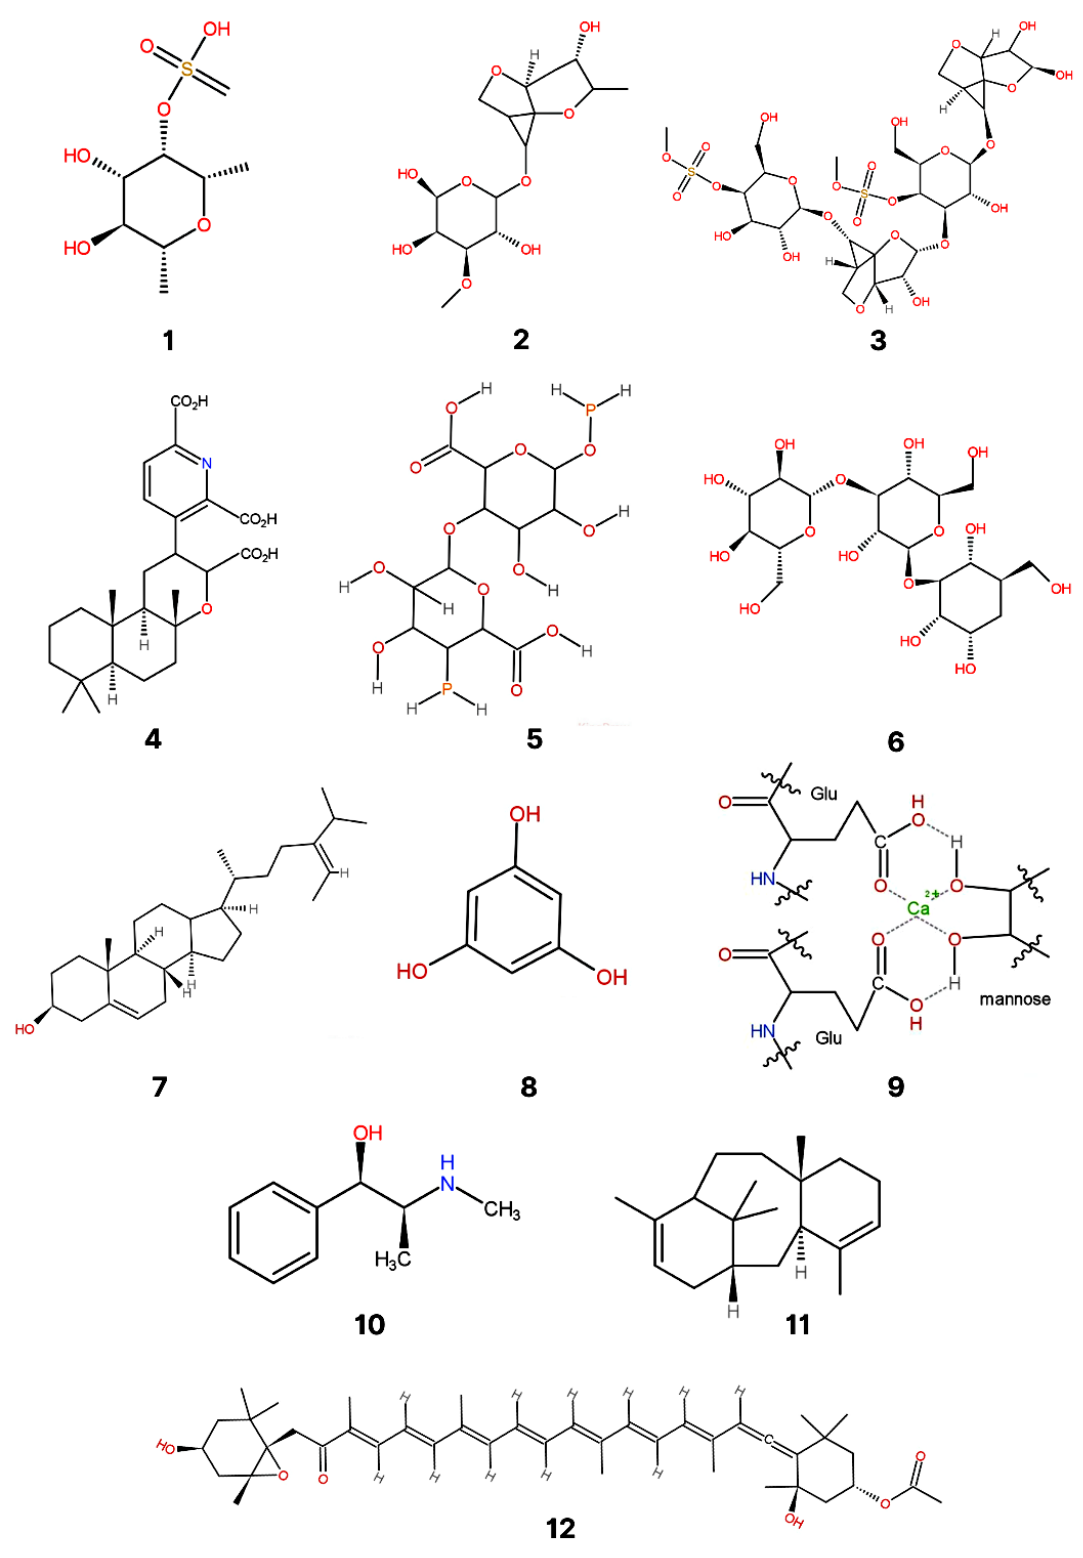
Figure 3. The chemical structures of fucoidan ( 1 ), agars ( 2 ), kappa carrageenans ( 3 ), ulvans ( 4 ), alginates ( 5 ), laminarin ( 6 ), fucosterol ( 7 ), phlorotannins ( 8 ), lectins ( 9 ), alkaloids ( 10 ), diterpenes ( 11 ), and fucoxanthin ( 12